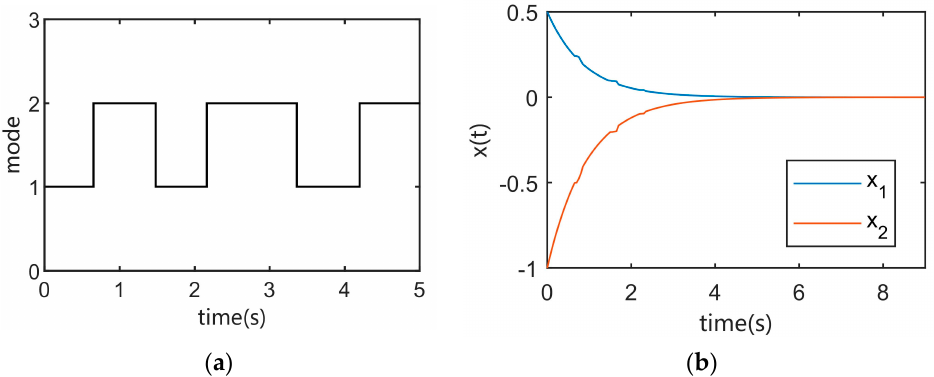
Figure 3. ( a ) Semi-Markov jump modes; ( b ) State response of the closed-loop system.